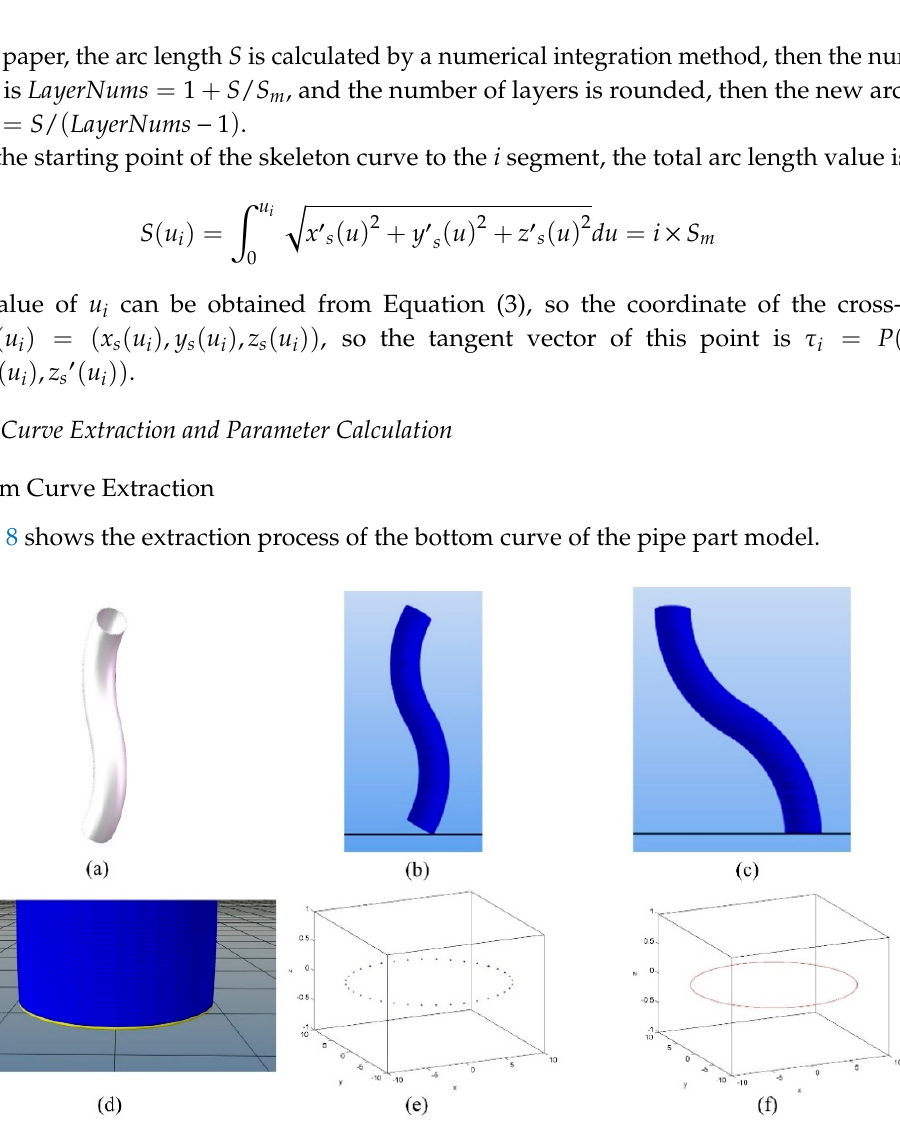
Figure 8. Bottom curve extraction process: ( a ) Designed model, ( b ) STL import, ( c ) Position adjustment, ( d ) Model slice, ( e ) Bottom points, ( f ) Bottom curve